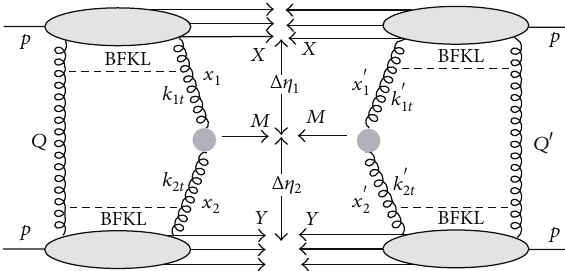
Figure 14: The inclusive double diffractive amplitude multiplied by its complex conjugate. A central system 𝑀 is produced with rapidity gaps Δ𝜂 1 and Δ𝜂 2 between proton dissociated products 𝑋 and 𝑌 ,